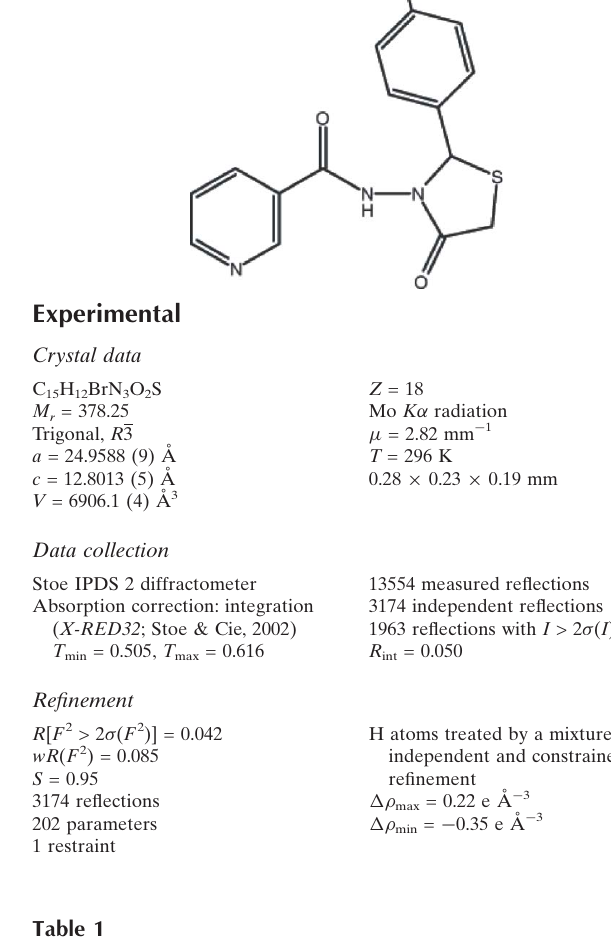
13554 measured reflections 3174 independent reflections